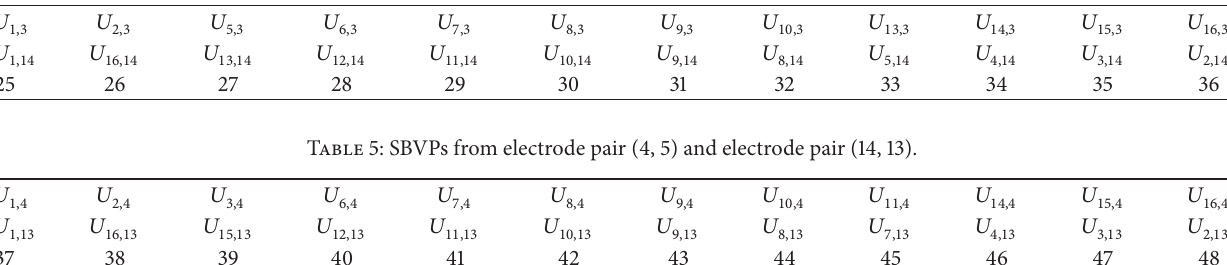
Table 4: SBVPs from electrode pair (3, 4) and electrode pair (15, 14).